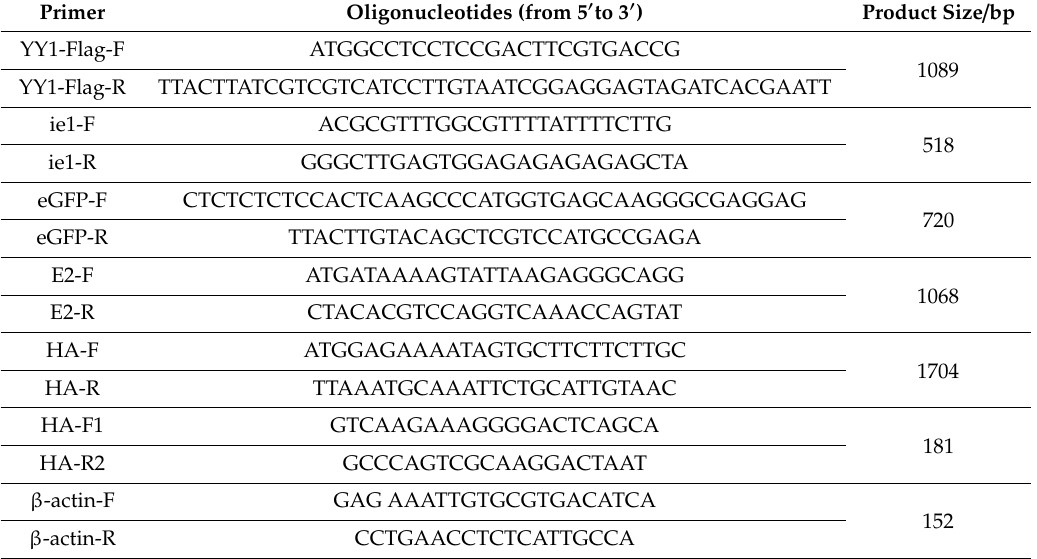
Table 1. Primers used in this